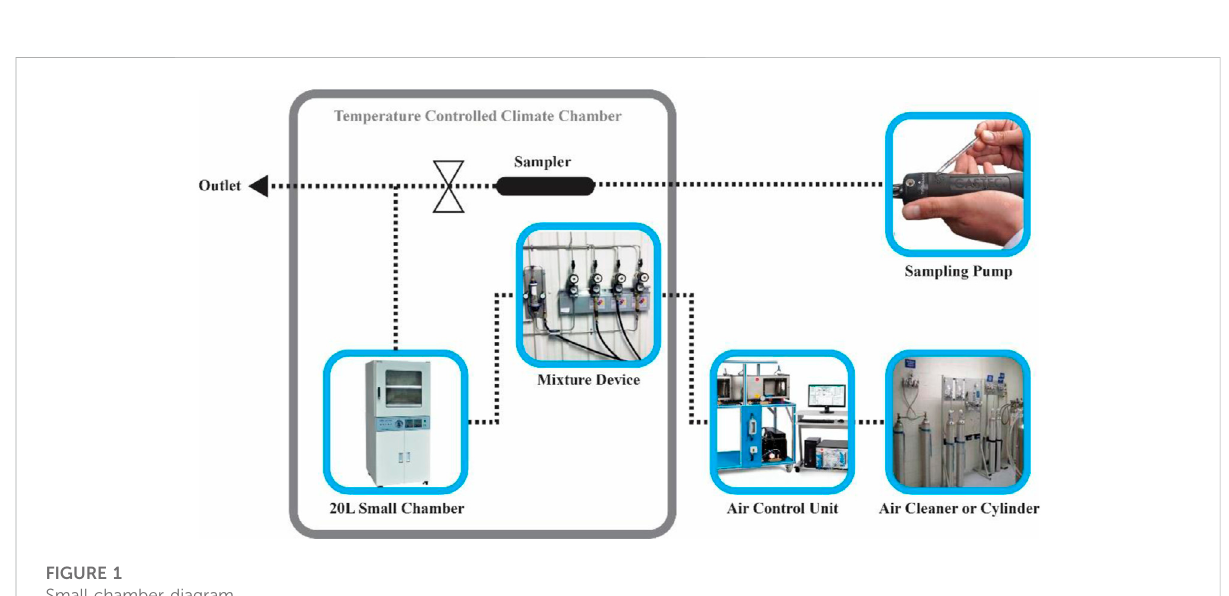
FIGURE 1 Small chamber